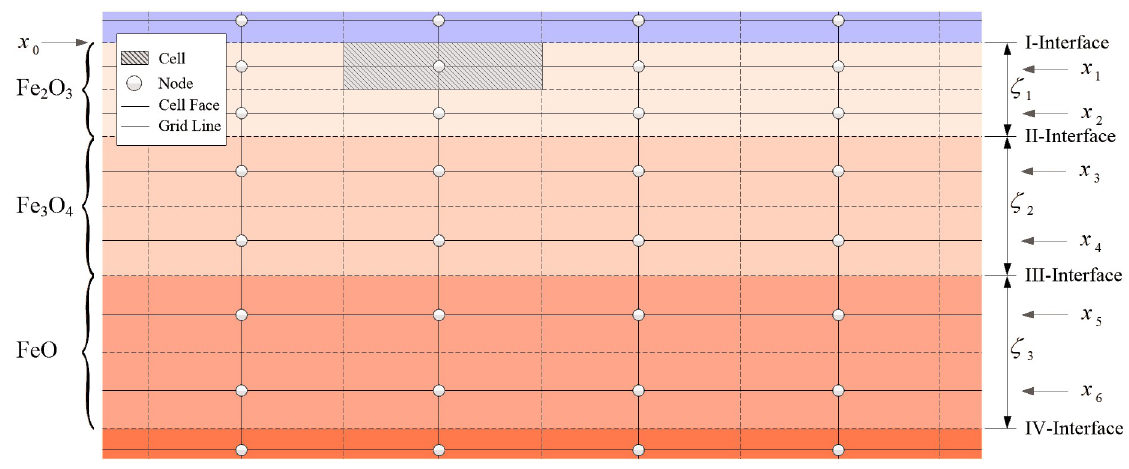
Fig 3. Grid treatment for the high-temperature